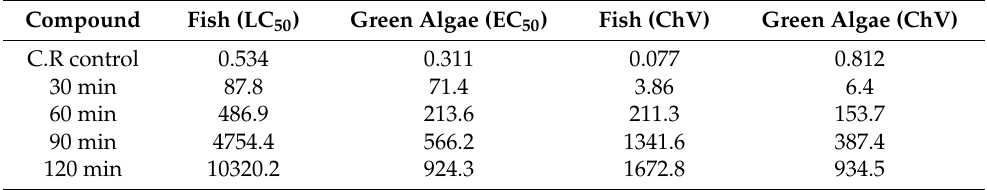
Table 3. Acute toxicity and chronic toxicity of C.R and the tread samples at different oxidation intervals using